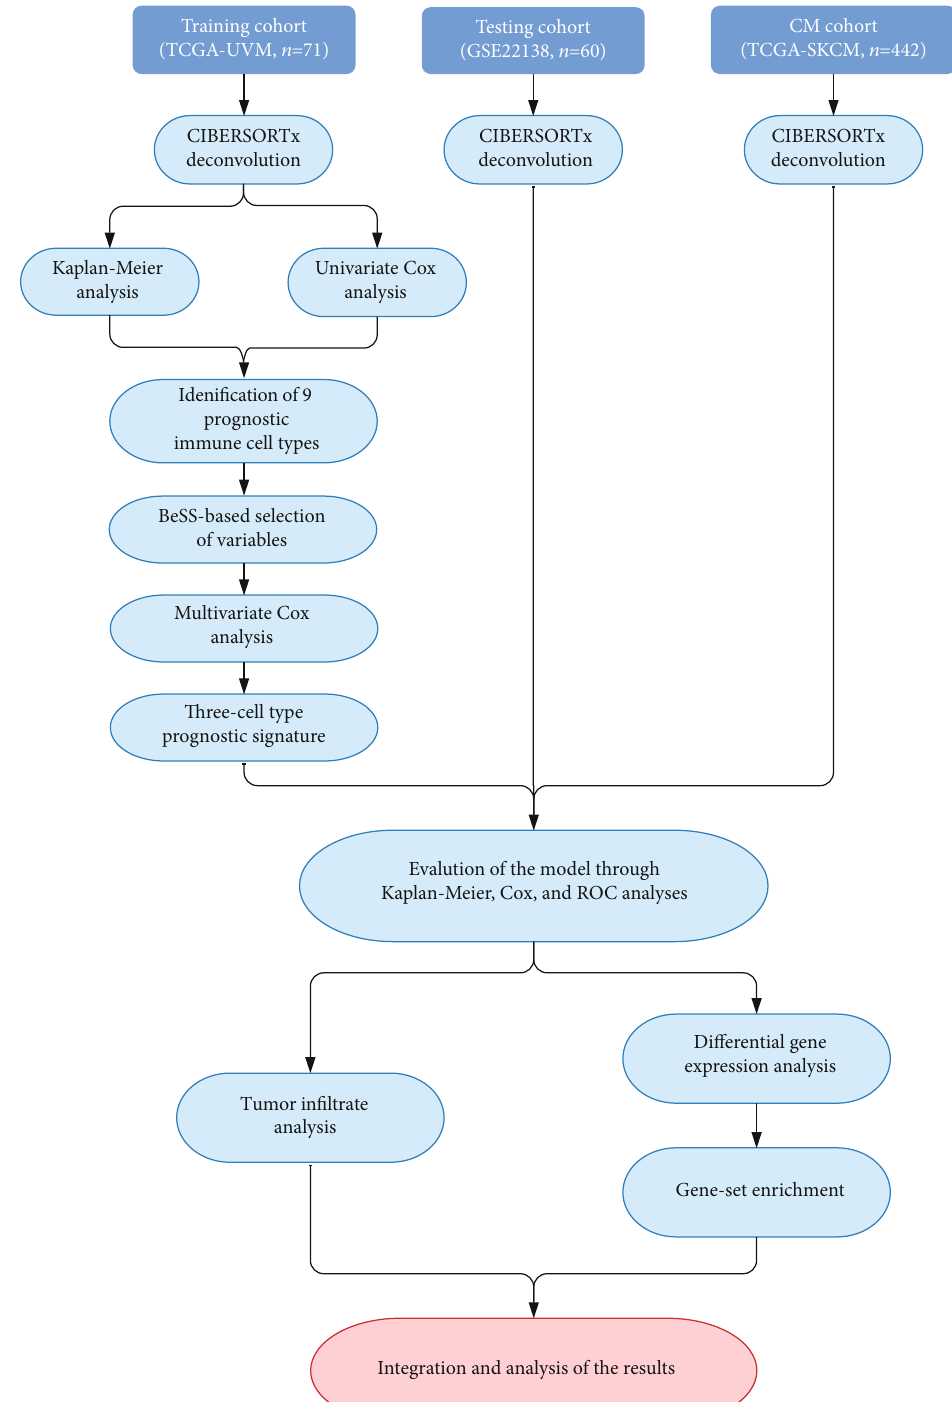
Figure 1: A simpli fi ed fl owchart of the